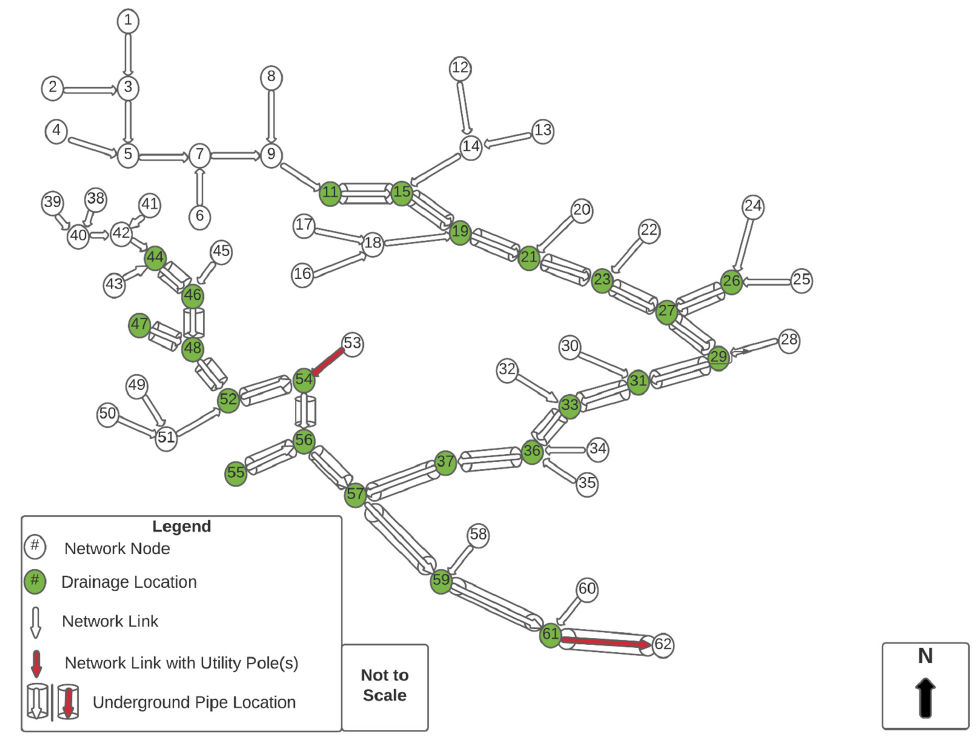
Figure 8. London. AR watershed network schematic for the 100-year storm. Some of the WSEs in Table 3 are high because the Whittier, NC watershed has a steep average slope and there are well-defined channels towards the confluence of the water- shed’s streams. These are where the flood-susceptible utility poles are located (Figure 6) and where cross-sections were taken in